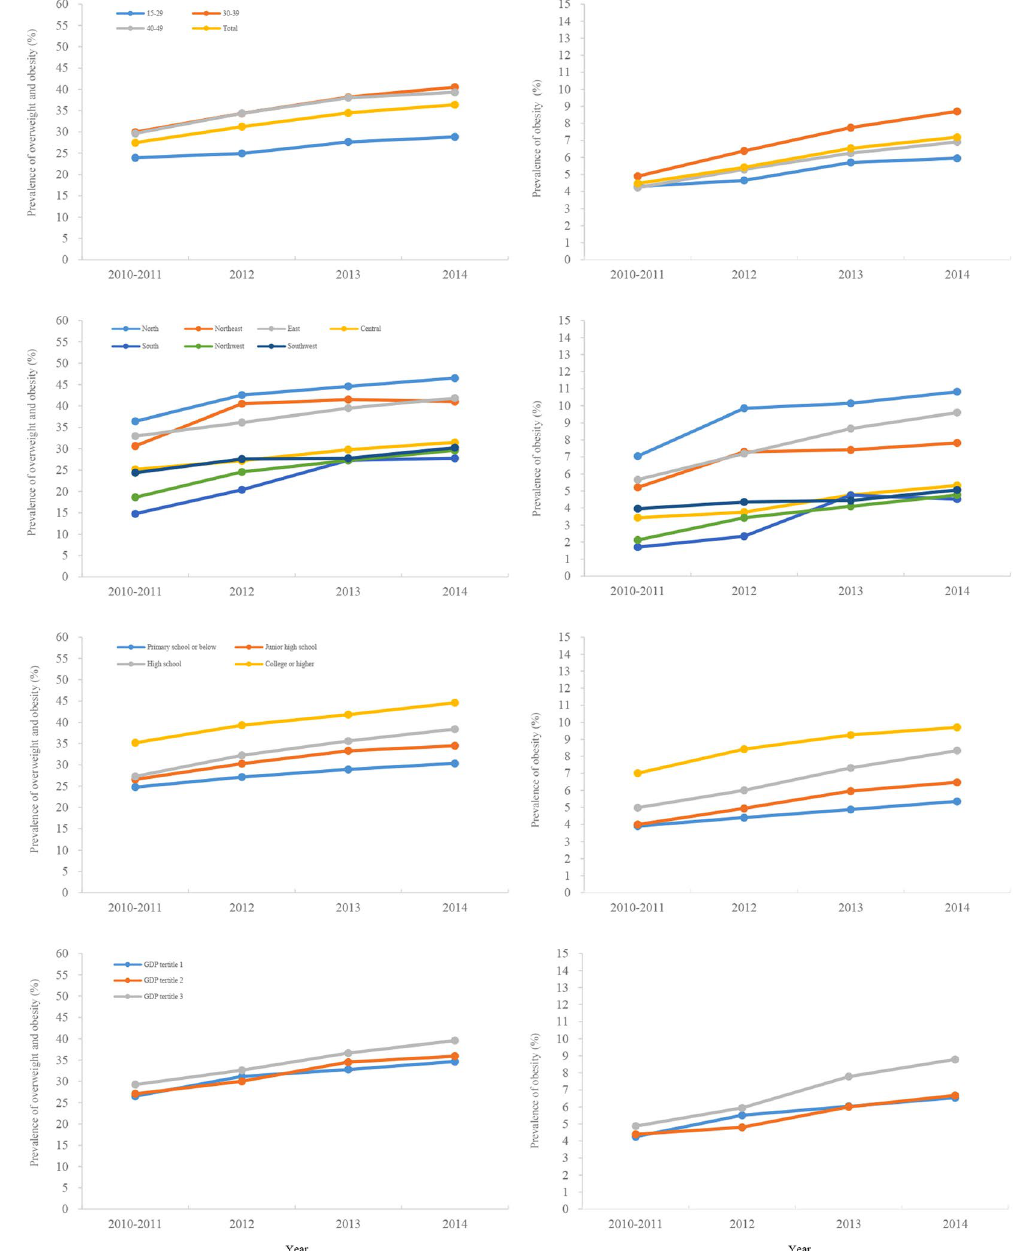
Figure 1. Prevalence and overweight and obesity among men aged 15–49 years by demographic variables, 2010–2014. Overweight and obesity were defined according to the Chinese criteria: overweight, 24.0 ≤ BMI ≤ 27.9 kg/m 2 and obesity, BMI ≥ 28.0 kg/m 2